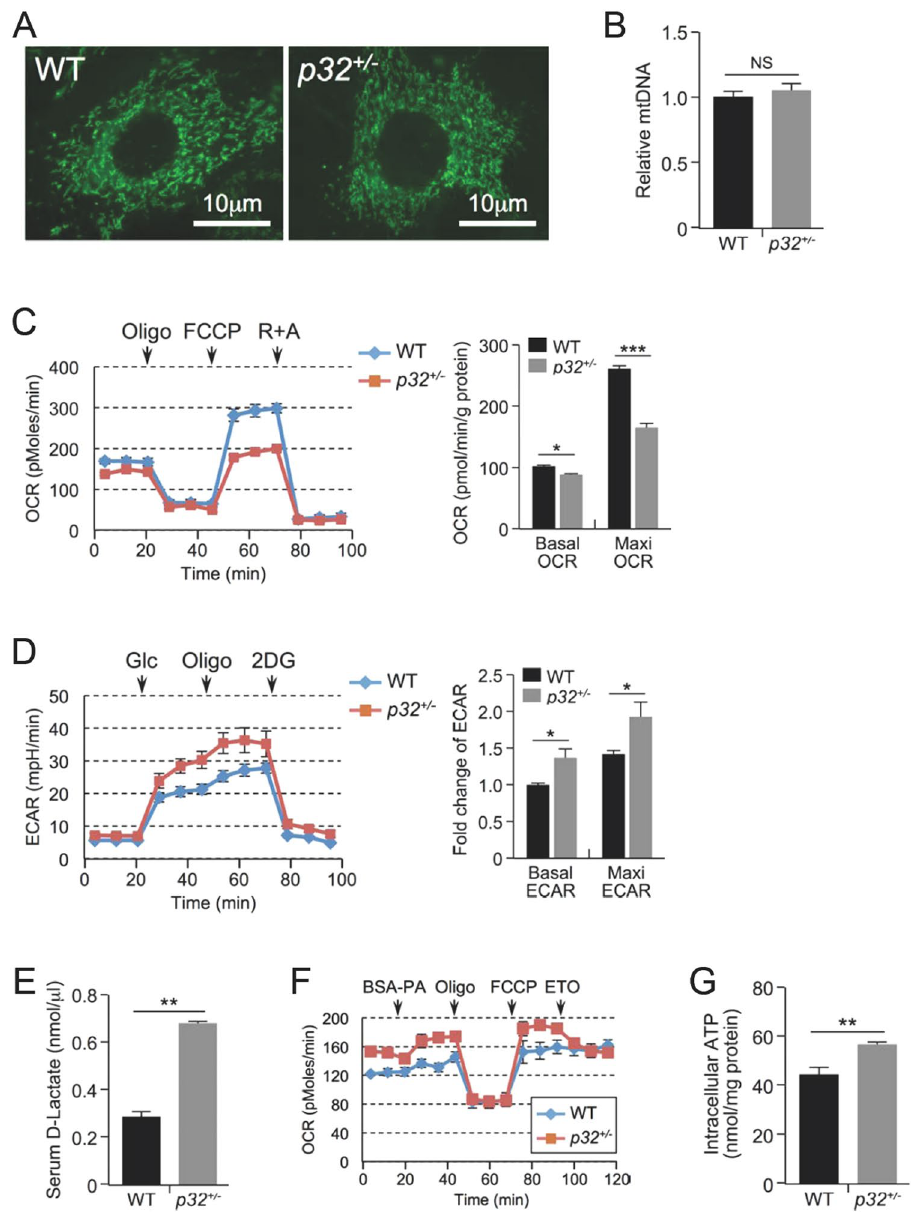
Figure 5. p32 heterozygosity decreases glucose oxidation and increases glycolysis and FAO. ( A ) Representative image of the mitochondria in WT and p32 + / − MEFs by Mito-Green staining. ( B ) Relative mtDNA amounts in WT and p32 + / − MEFs determined by mtDNA/nuclear DNA ratio using qPCR. mtDNA: mCO1; nDNA: NDUFC1. ( C ) Basal oxygen consumption (basal OCR) and maximum mitochondrial respiration capacity (Maxi OCR, indicated by OCR in the presence of FCCP) in the presence of 25 mM glucose in WT and p32 + / − MEFs determined using a Seahorse XF24 analyzer. Left, representative curve; Right, quantification of three independent experiments. ( D ) ECAR in WT and p32 + / − MEFs determined using a Seahorse XF24 analyzer. ECAR upon glucose injection (indicated by Glc) minus that of 2DG injection represents the basal ECAR; ECAR with oligomycin injection (indicated by Oligo) minus that with 2DG injection represents maximum glycolytic flux. Left panel, representative curve; Right panel, quantification of three independent experiments. ( E ) Serum lactate levels of 52-week-old mice fed NC (n = 4). ( F ) Basal oxygen consumption (basal OCR) and maximum mitochondrial respiration capacity (Maxi OCR, indicated by OCR in the presence of FCCP) in the presence of 150 μ M palmitate in WT and p32 + / − MEFs determined using a Seahorse XF24 analyzer. ETO (50 μ M) was used as a system control. OCR without ETO minus that with ETO indicated the FAO-specific OCR. ( G ) Intracellular ATP levels in WT and p32 + / −